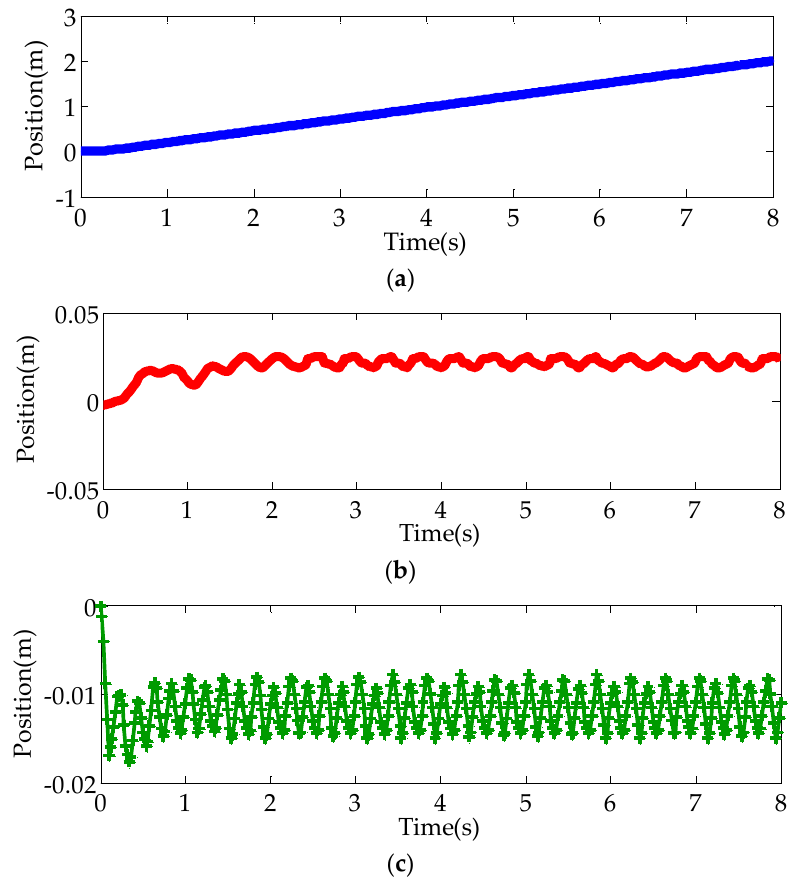
Figure 8. Displacement curves for centroid of robot trunk. ( a ) Position variations along x-axis. ( b ) Position variations along y-axis. ( c ) Position variations along z-axis.